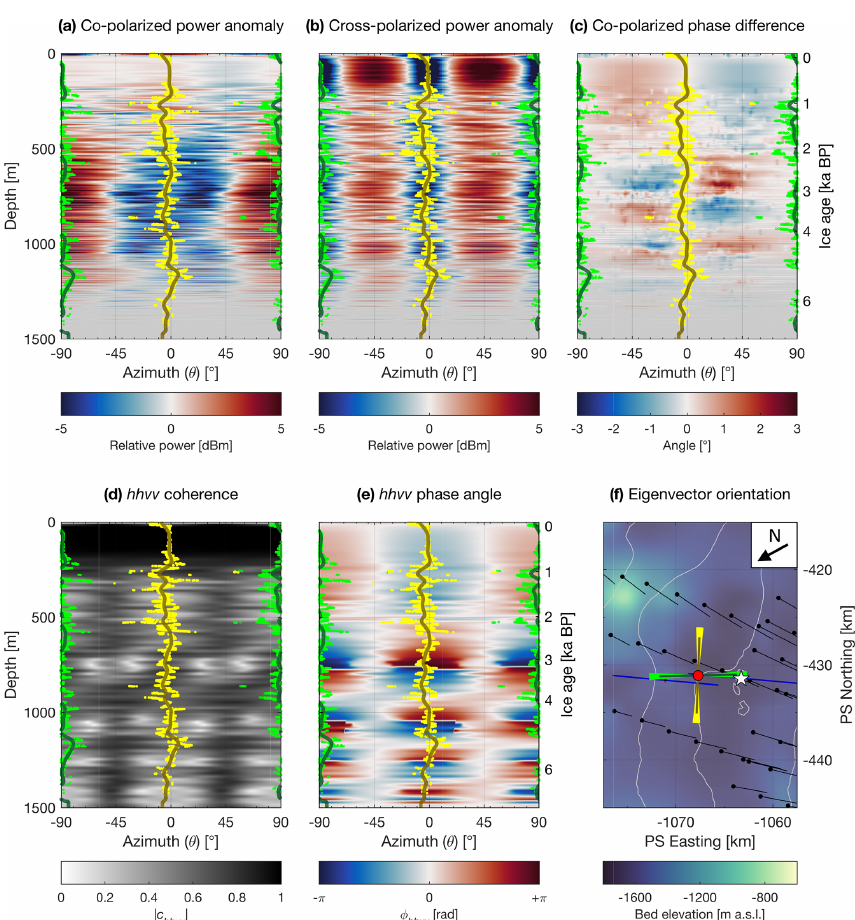
Figure 4. Polarimetric power and coherence measured using ApRES at WAIS Divide identifying the orientations of the E 1 (green) and E 2 (yellow) eigenvectors. (a) Co-polarized and (b) cross-polarized power anomaly. (c) Co-polarized phase difference. Quad-polarized ( hhvv ) (d) coherence and (e) phase angle. (f) Orientation of the E 1 and E 2 eigenvectors (dark lines) and their respective uncertainties (bright arc patches). The two eigenvector orientations (dark lines) were calculated using a Gaussian-weighted moving average of the azimuthal minima (bright dots). The depth-dependent gradient along the orientation of the E 1 eigenvector represents E 2 − E 1 , the fabric asymmetry of the measured vertical ice column. Map shown in (f) is an inset of Fig. 2b, with ice flow oriented approximately SW (230 ◦